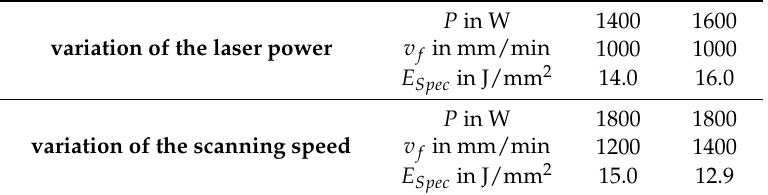
P in W 1400 1600 v f in mm/min P in